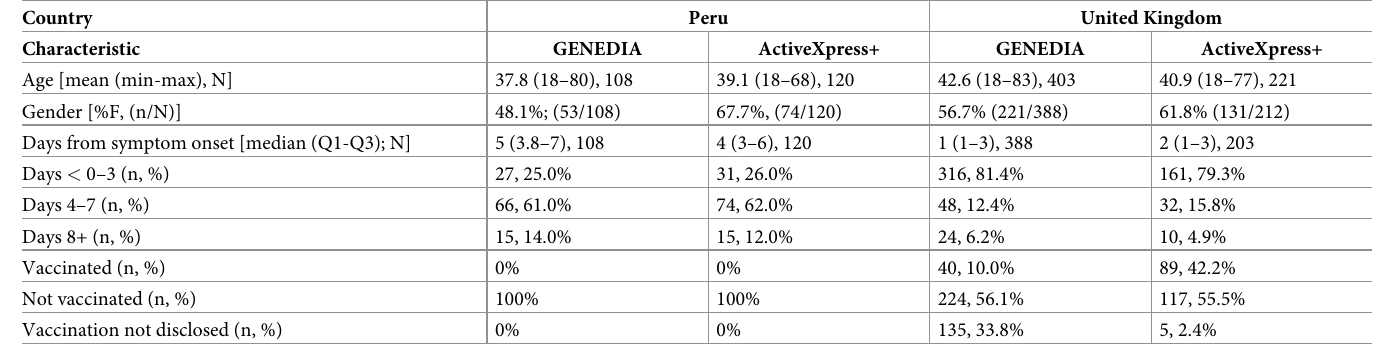
Table 1. Demographics of Ag-RDT clinical evaluation cohorts for Peru and United Kingdom.